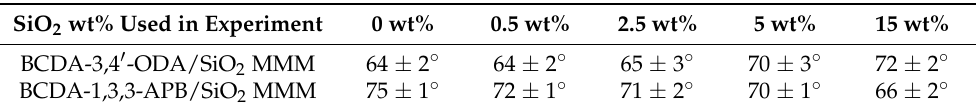
Table 2. Water contact angles of pristine alicyclic PI membranes and their related PI/SiO 2 mixed matrix